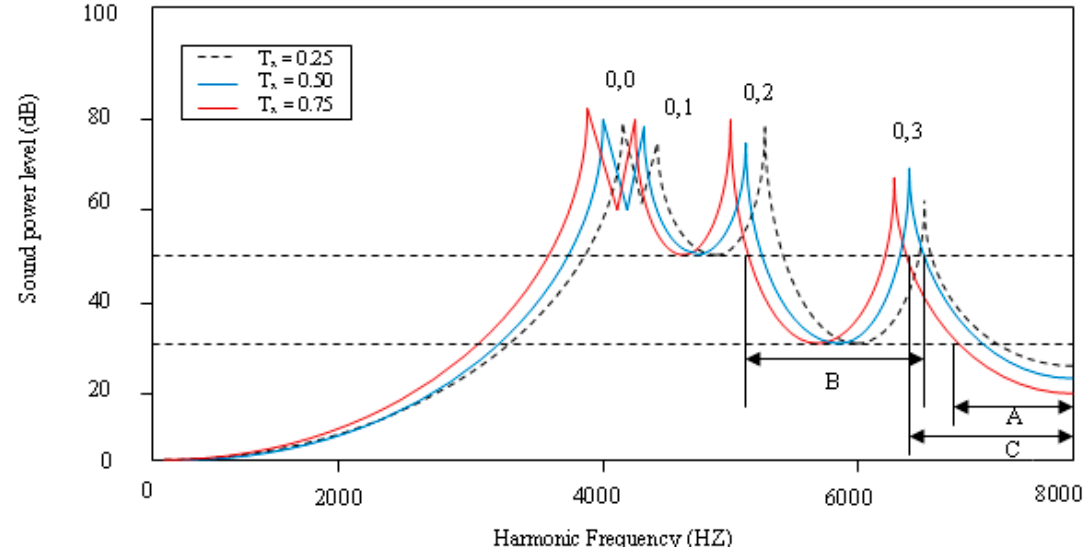
Figure 11. Numerical comparison of sound power level for annular plate attached with 2 rectangular stiffener patches and having parabolic decreasing thickness variations (Case I) for different taper ratios T x .